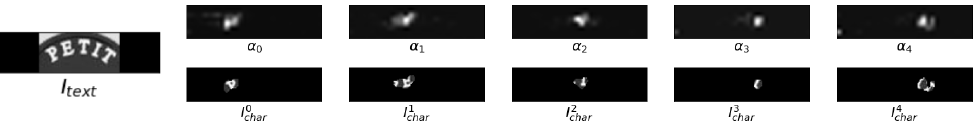
Figure 3. An overview of character image cropped by the upsampled binary attention map from text image. The attention maps generated from DAN are shown in the first line. In the second line, the character image is cropped by the upsampled binary attention